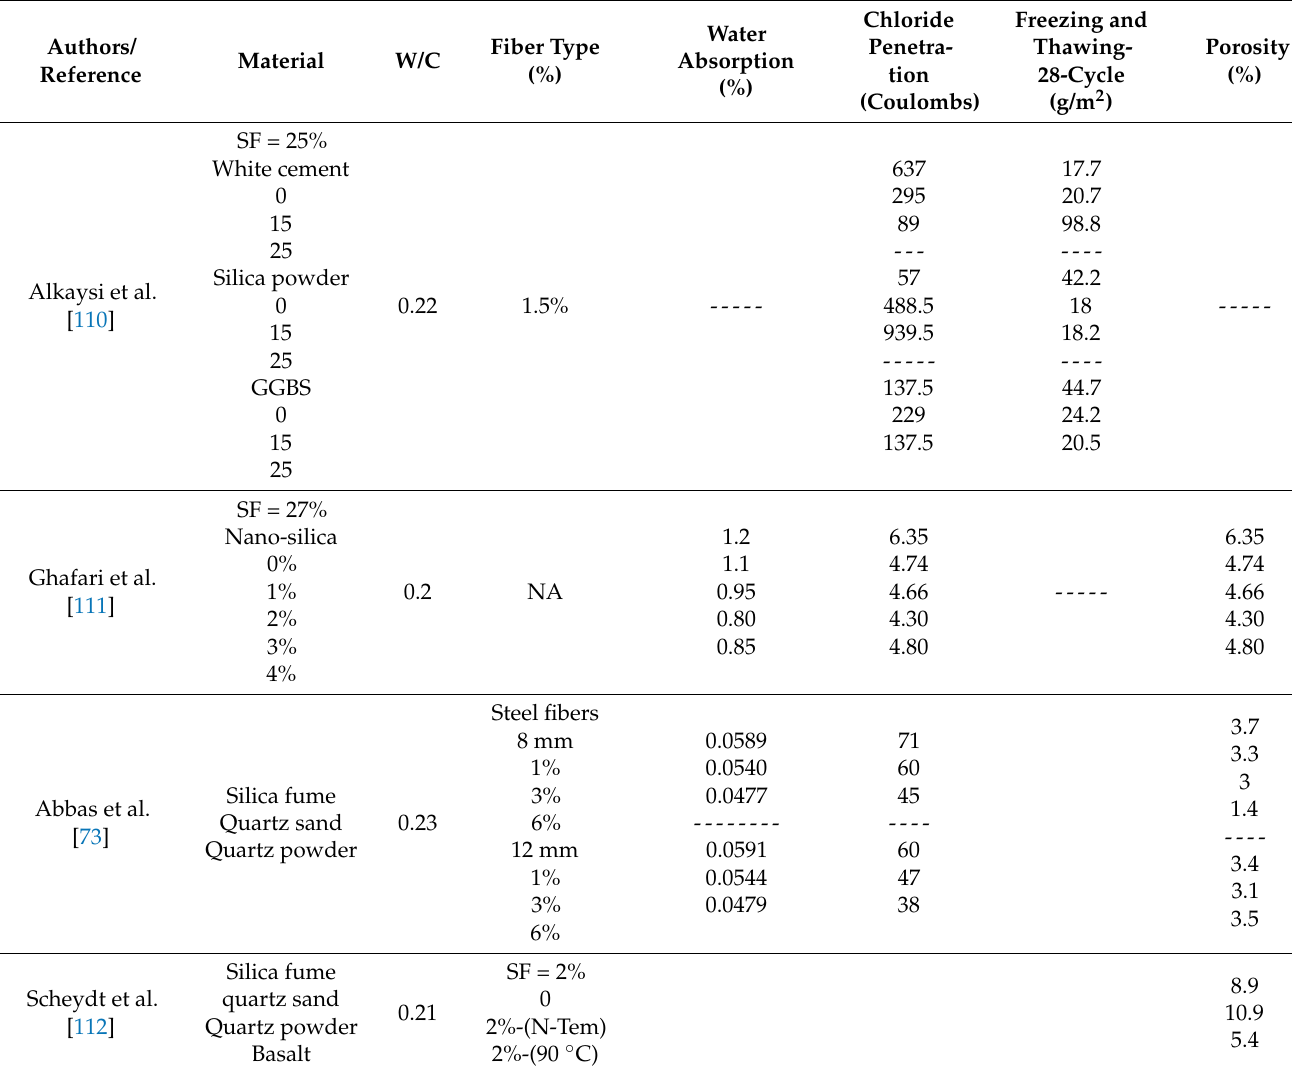
Table 5. Summary of durability performance of